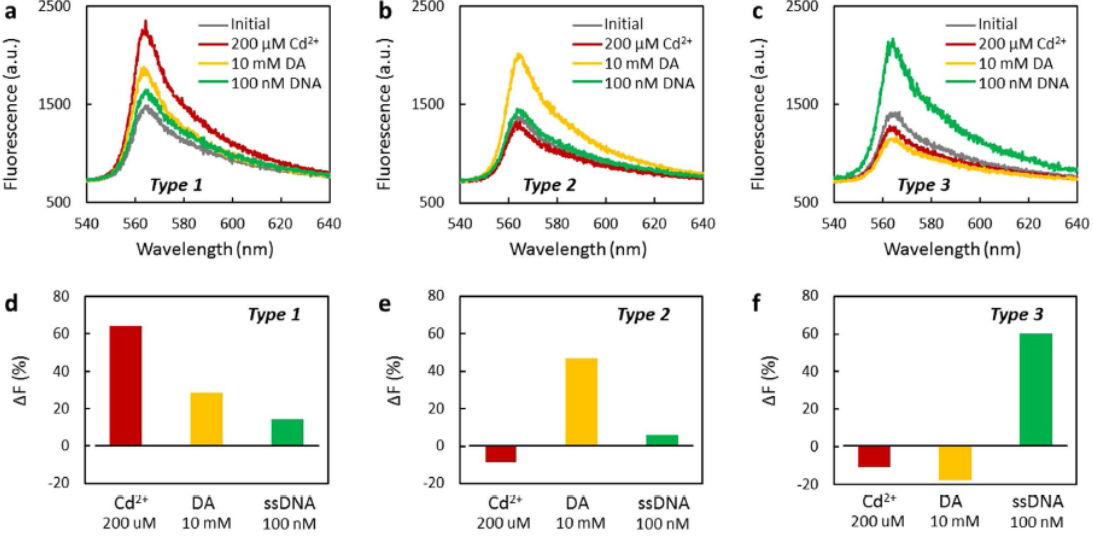
Figure 15. Fluorescence spectra of Type 1 ( a ), Type 2 ( b ) and Type 3 ( c ) sensor when immersed in 200 μM Cd 2+ (red curve), 10 mM DA (yellow curve) and 100 nM (green curve).( d – f ), Histograms: the fluorescent restoration ratio of Type 1 ( d ), Type 2 ( e ) and Type 3. Reprinted from [142] under a Creative Commons CC-BY license.